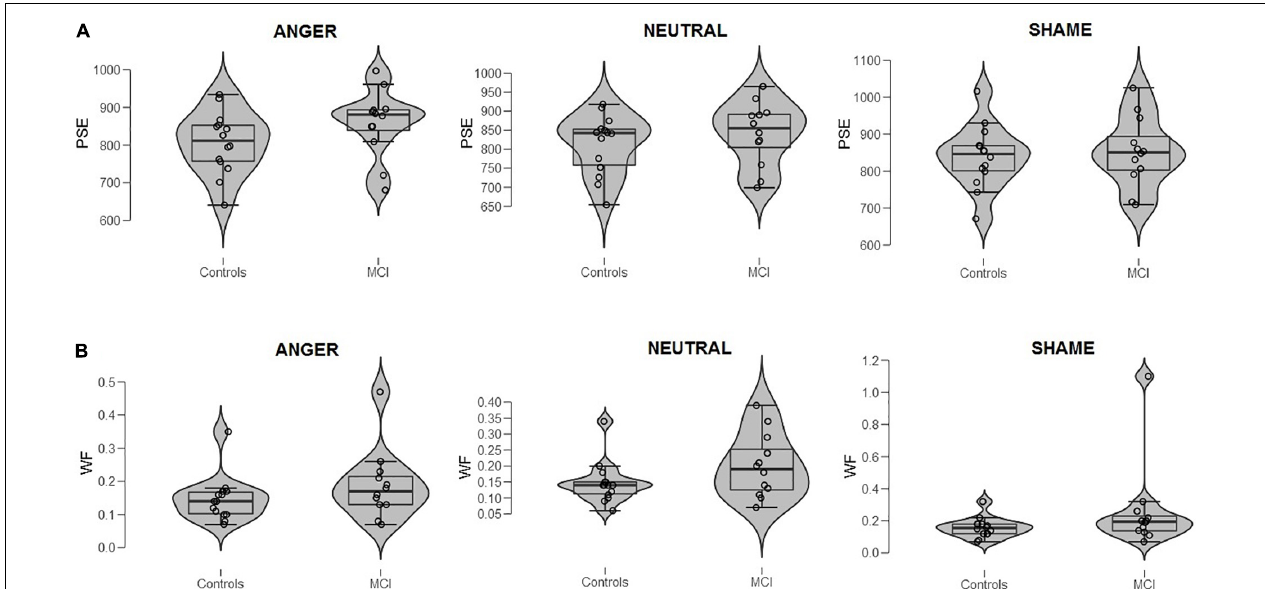
FIGURE 1 | (A) Bisection point (BP) and (B) Weber ratio (WR) of the time bisection task as a function of Group (MCI and control) and Emotion (anger, shame, and neutral). Each dot represents a single